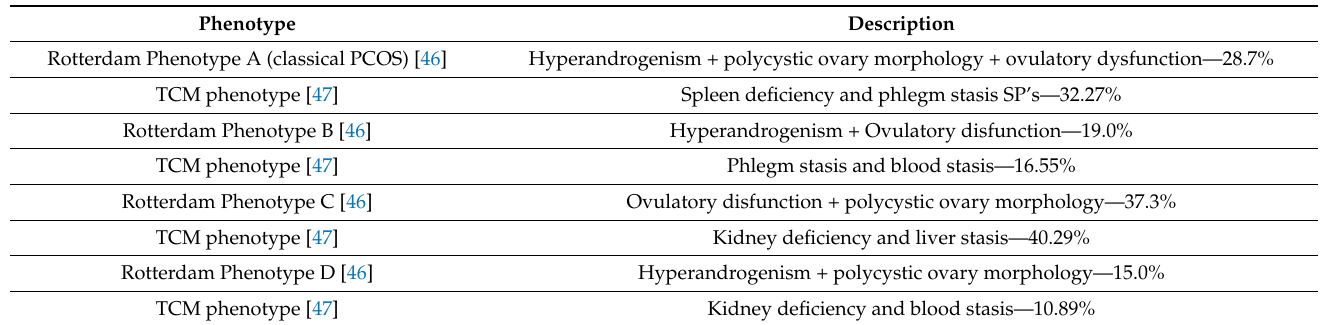
Table 1. Rotterdam phenotypes for PCOS women with correspondent TCM